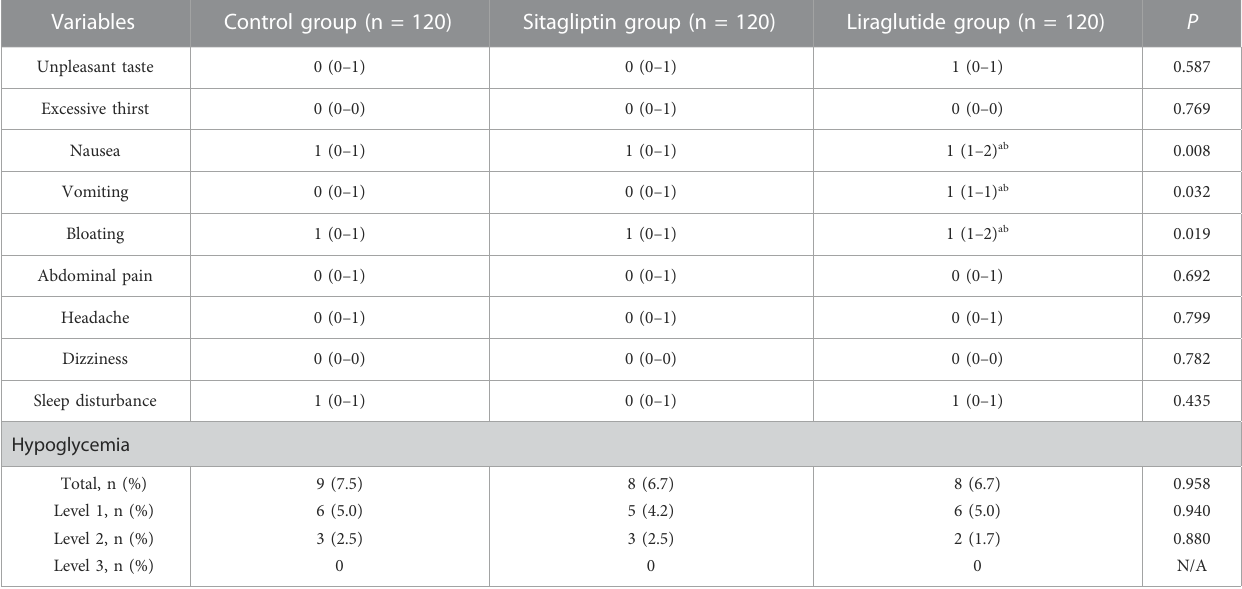
TABLE 4 Lawrance Tolerability Scores and